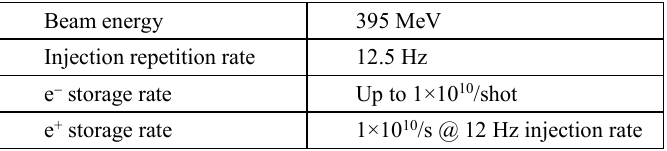
Fig. 1 IC serving two colliders. Table 1. IC parameters.